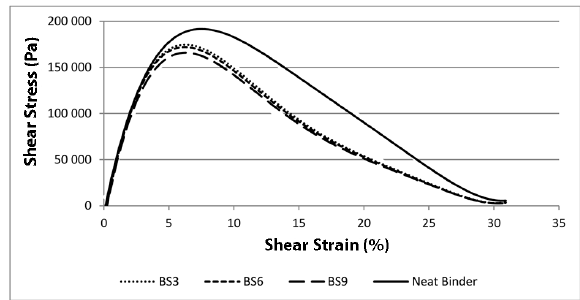
Fig. 5. Stress-strain curves extracted from LAS testing of siliceous modified binders